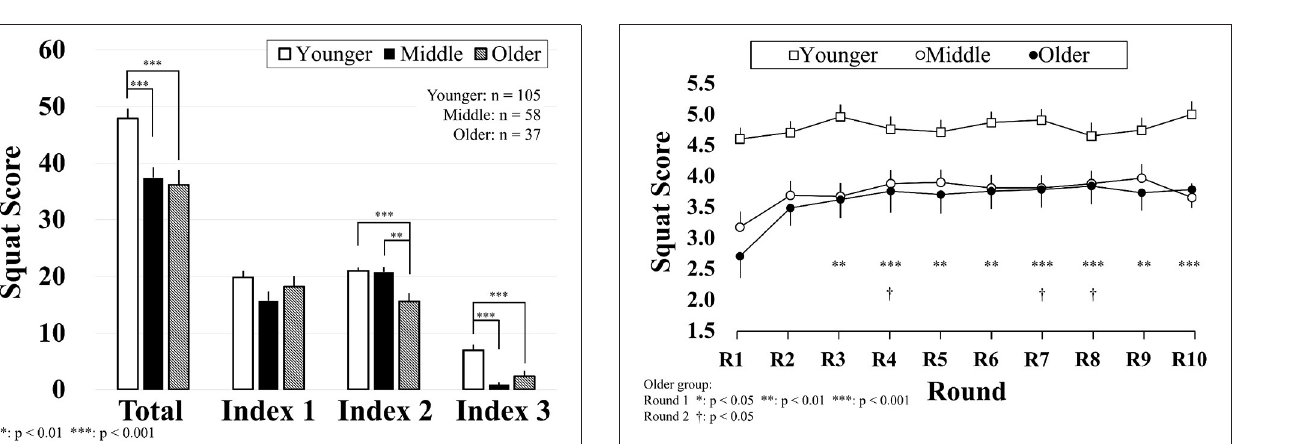
FIGURE 7 | Results of squat scores at each round. Data are mean value and standard